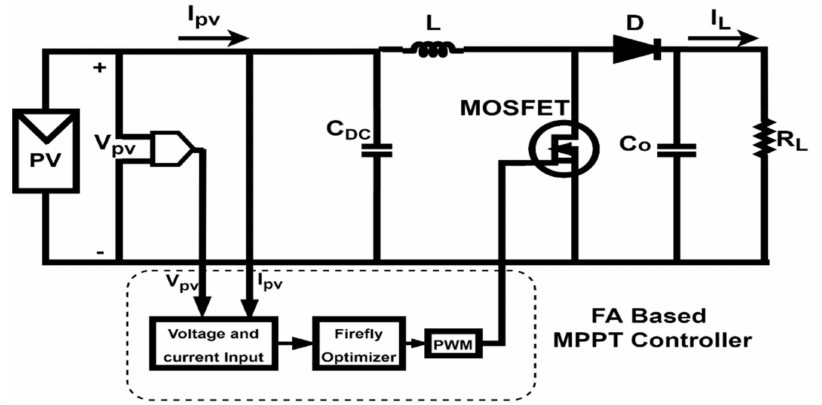
Figure 7. Schematic diagram of system.